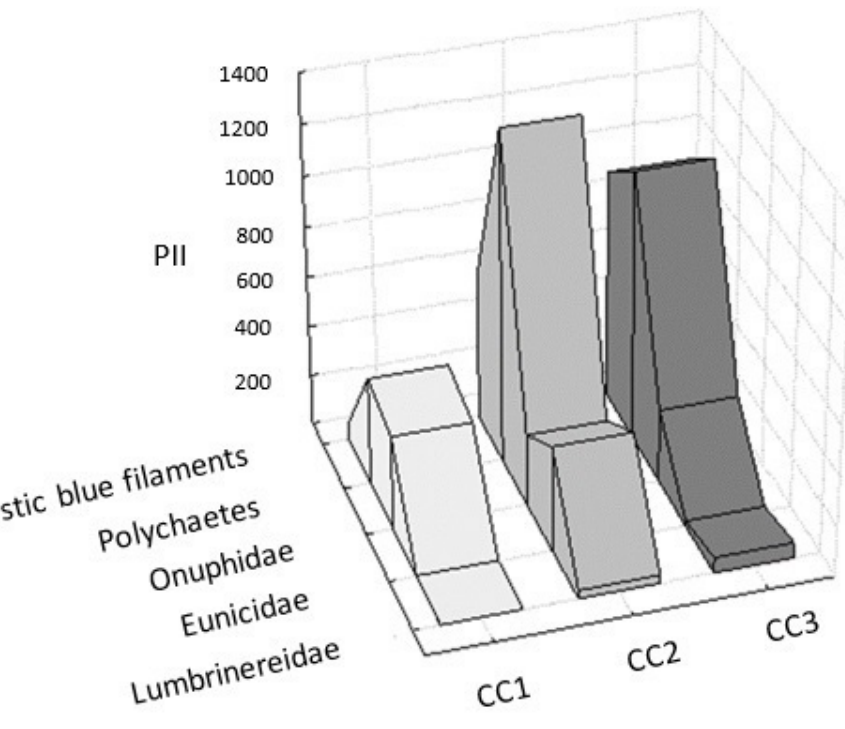
Figure 6. Trends of PII’s values of microplastics, total polychaetes and related families according to three size classes (1: small; 2: intermediate; 3: large) of Coelorinchus caelorhinchus (CC) from a sample from the bathyal plane of the Central Thyrrhenian Sea.